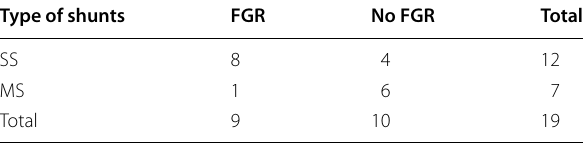
No significant difference was observed in the incidence of FGR between the single- and multiple-shunt groups. The p value of Fisher’s exact test (2-sided) was